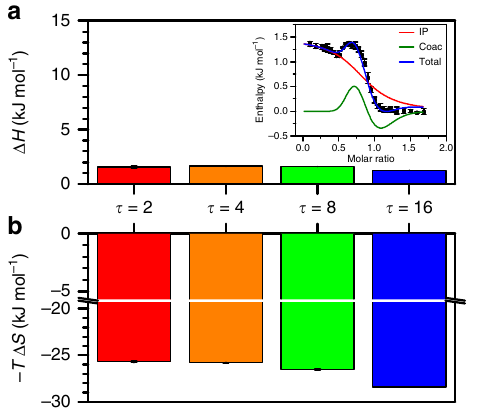
Fig. 3 Isothermal titration calorimetry (ITC) shows that sequence effects in coacervation are entropically driven. a The enthalpic contribution to coacervation as a function of τ is small, positive, and does not show signi fi cant differences between sequences. Isothermal titration calorimatry captures this thermodynamic value via a fi t to an established two-step coacervation model (inset) that distinguishes between enthalpic contributions from ion pairing (IP) and coacervation (Coac) steps 48 . b The entropic contribution to the coacervation free energy is large, negative, and attributed to counterion release. Clear differences are observed as a function of τ , with an increasing entropic driving force with increasing blockiness (larger τ τ , concomitant with the changes in the width of the coexistence region and the CSC observed in simulation and experiment.